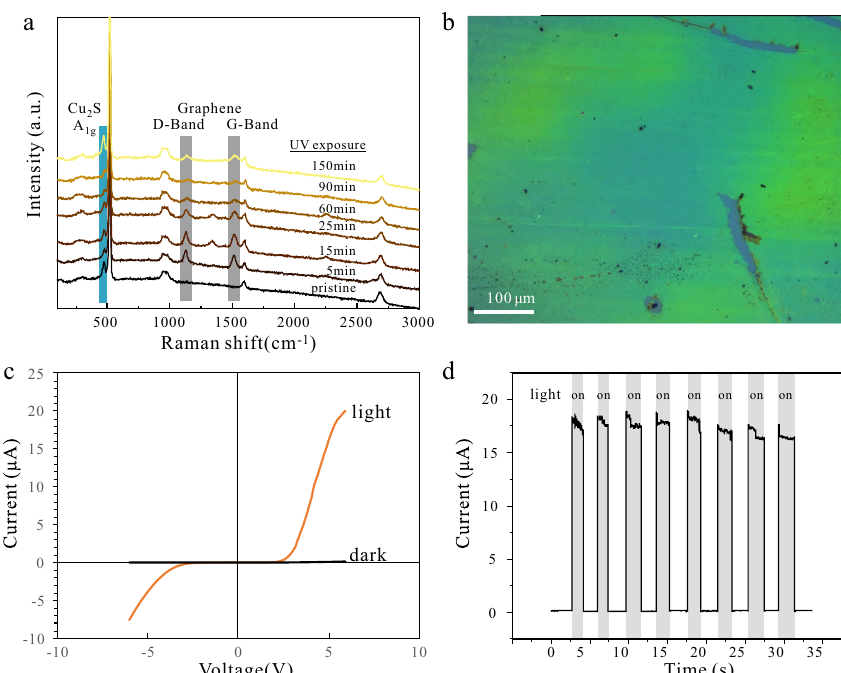
Fig. 5 Application of TMMCs to optoelectronic devices. a Raman spectra after varying duration of ozone exposure, indicating high environmental stability. b Optical micrograph of continuous Cu 2 S fi lms (tears in the fi lm expose the substrate and are due to the transfer process), c current-voltage characteristics for continuous Cu 2 S fi lm under dark and illuminated conditions, d time evolution of photocurrent under pulsed